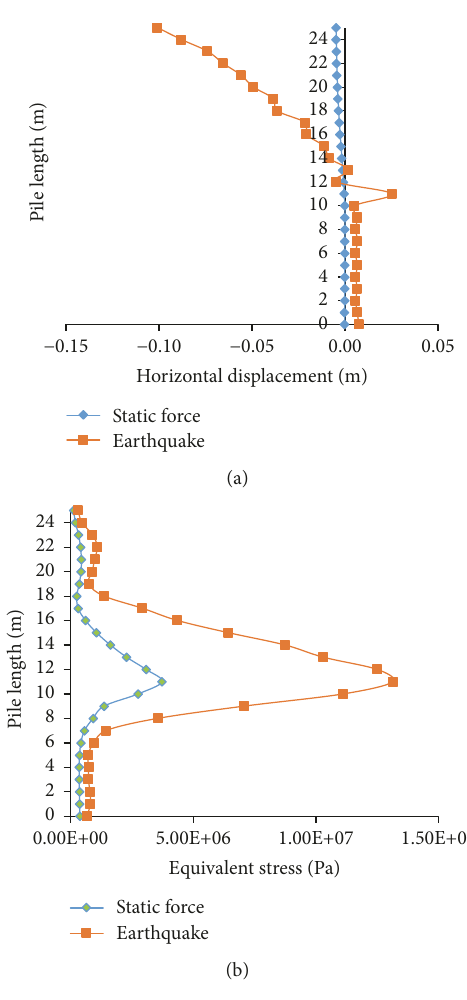
Figure 15: The dynamic response curve of stabilizing pile. (a) Horizontal displacement; (b) equivalent